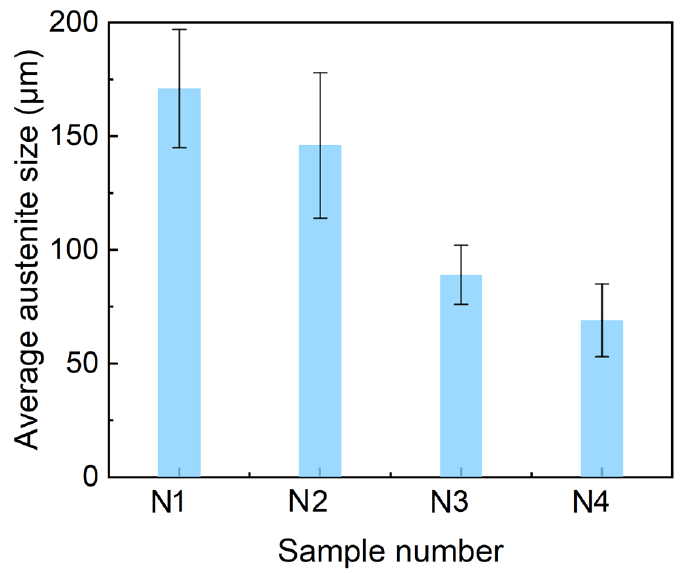
Figure 10. The average size of austenite grain in N1, N2, N3, and N4 steel.